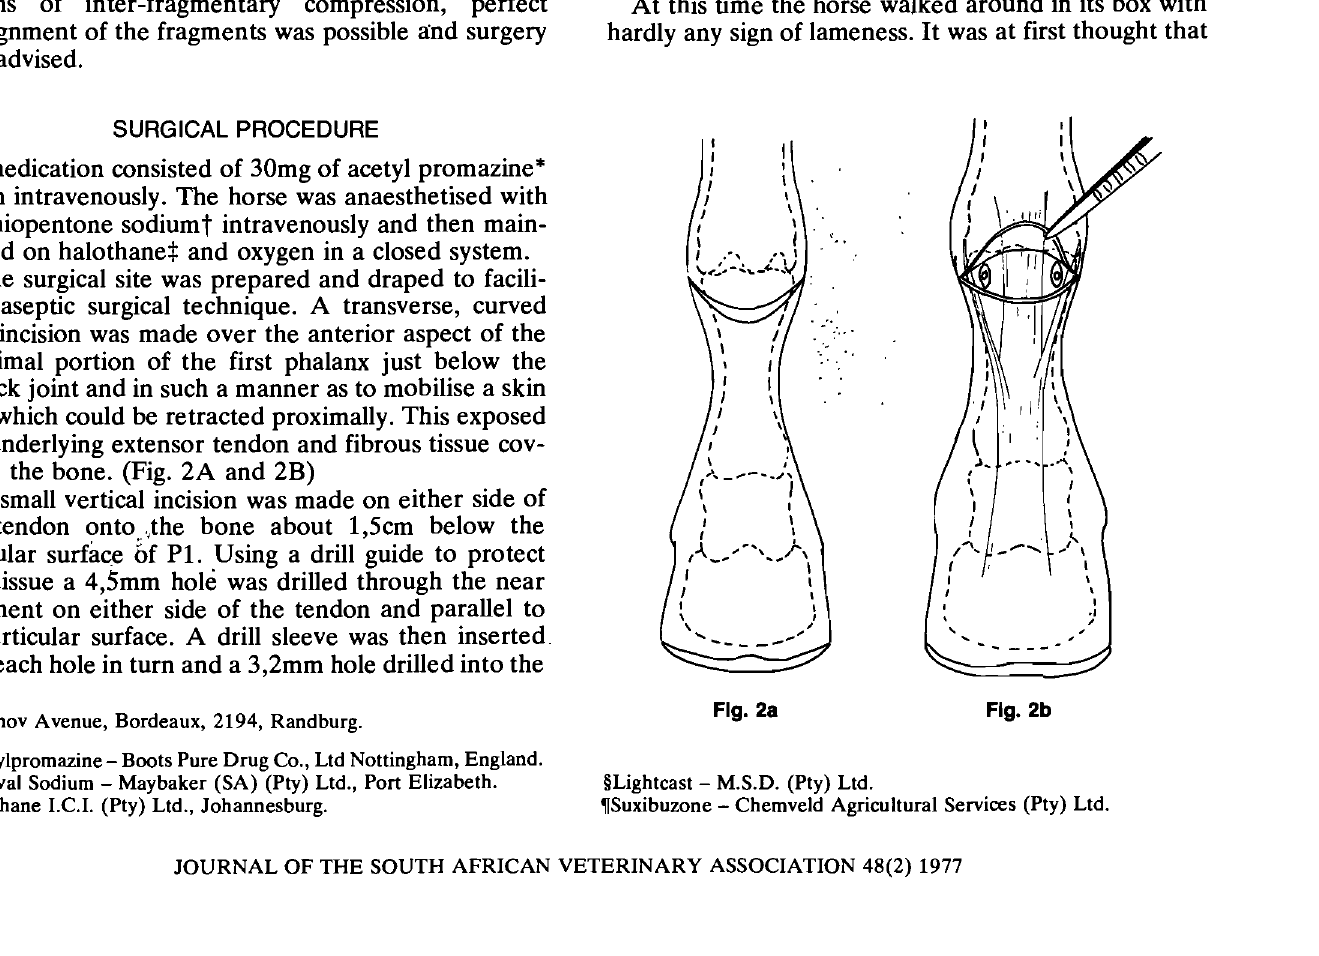
§Lightcast - M.S.D. (Pty)